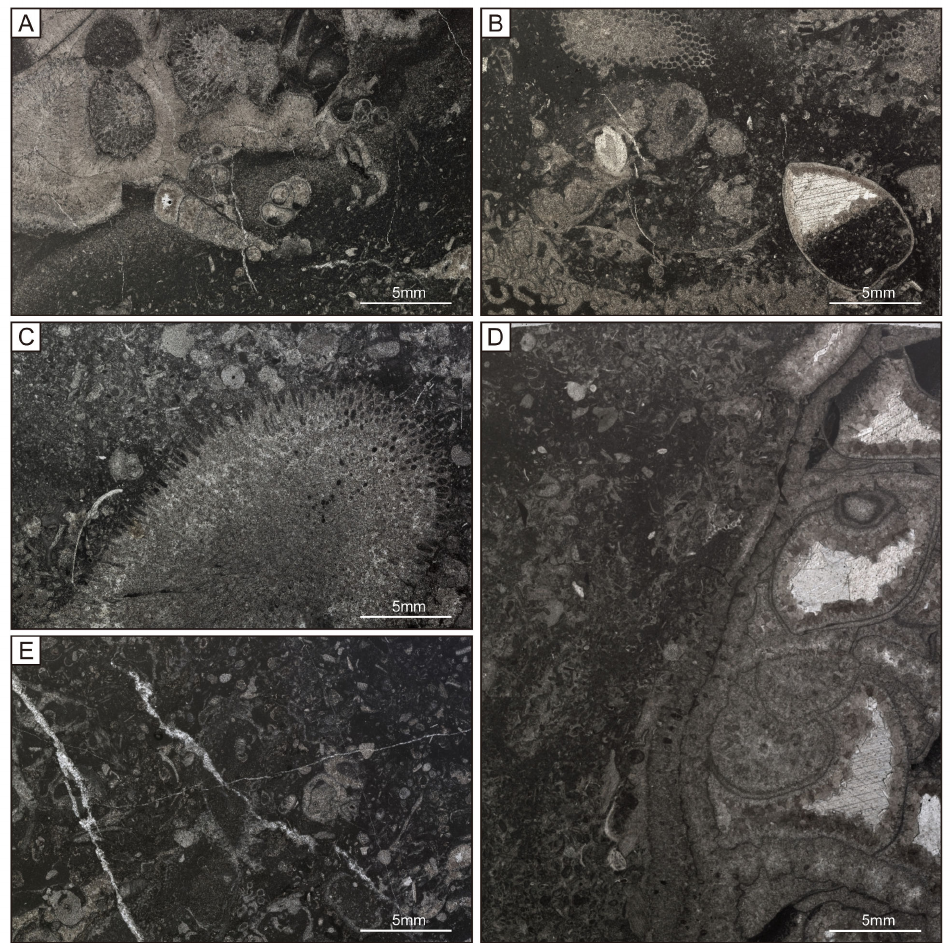
Figure 5. Photomicrographs of microfacies belong to the heterozoan reef core stage: ( A , B ) benthic organisms bindstone; pore spaces filled by equant spar calcite cement; ( C ) Filled-skeleton sponge framestone; ( D ) filled-skeleton sponge framestone; the chamber of Sphinctozoan sponge; ( E ) organisms-bioclastic limestone with calcite